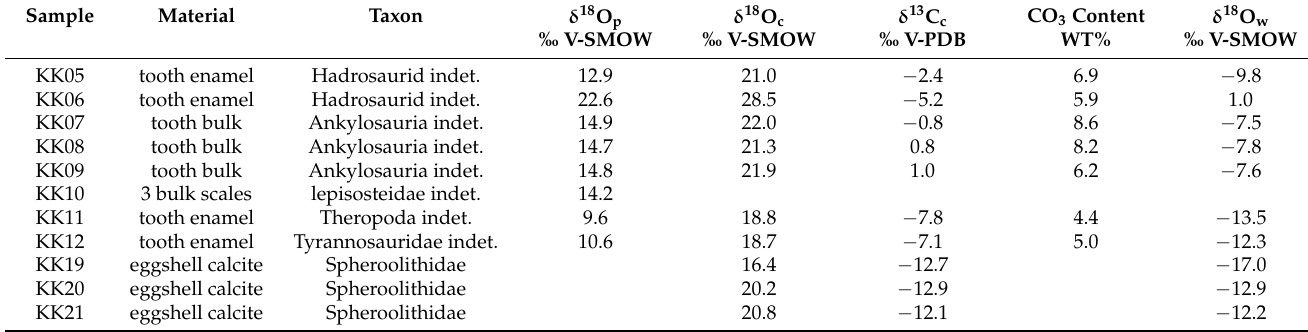
Figure 1. Present-day ( A ) and latest Cretaceous ( B ) position of the Kakanaut area plotted as a yellow arrow on a paleogeographic reconstruction [41]. ( C – G ): example of analyzed teeth and eggshells, including the tyrannosaurid tooth KK12 ( C ), the hadrosaurid tooth KK06 ( D ), a spheroolithid ( E ) and prismatoolithid ( F ) eggshell fragments, and an ankylosaurid tooth KK08 ( G ). Table 1. Carbon and oxygen isotope compositions of apatite phosphate ( δ 18 O p ) and carbonate ( δ 13 C c , δ 18 O c ) and eggshell calcite from vertebrates reported along with the weight percent of apatite-bound carbonate, sample number, apatite material and taxonomy. The last column corresponds to the oxygen isotope composition of water ( δ 18 O w ) estimated from the δ 18 O p value of tooth apatite phosphate or the δ 18 O c value of eggshell calcite using existing fractionation equations (see